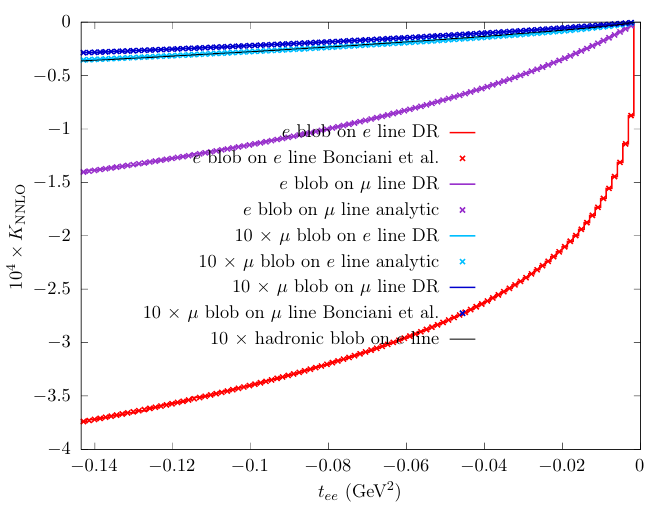
Figure 12. The same as figure 11 for the t ee